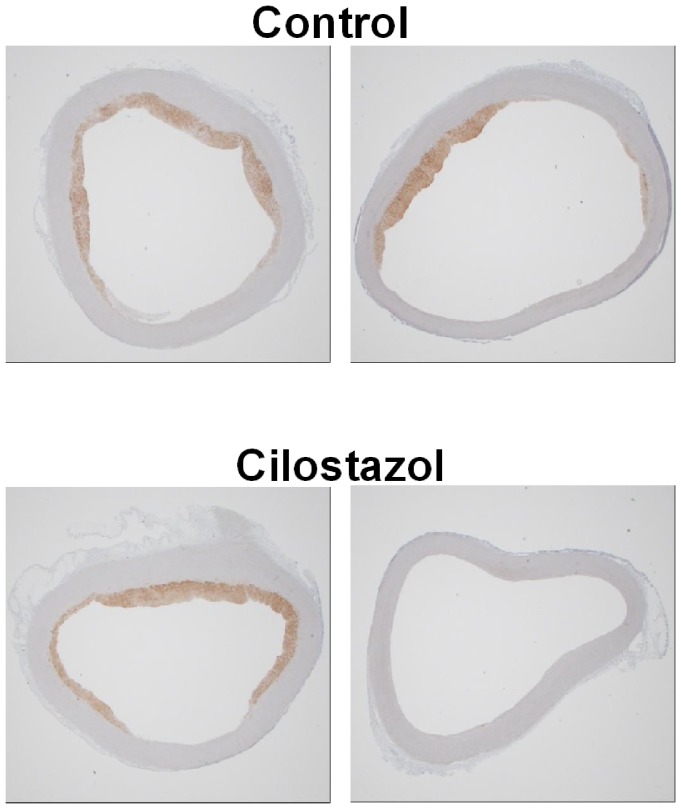
Immunohistochemical staining of macrophages in the proximal ascending aorta.Cross sections of the proximal ascending aorta were stained by an anti-macrophage RAM11 antibody. The brown part represents the macrophage-positive area. Typical images are shown for the control and cilostazol groups. Two of the five samples in the cilostazol group were not stained by the RAM11 antibody (the right image of cilostazol), although all samples were stained in the control group.